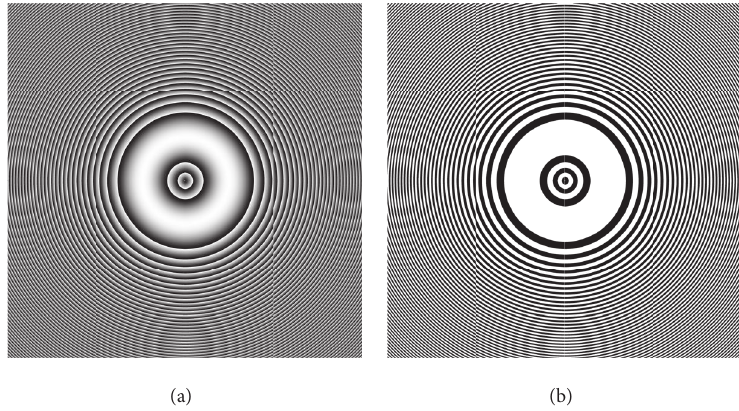
Figure 3: The phase distribution of the ideal diffractive kinoform (a) and binary (b) lens structure designed for the plane wave illumination, where white areas introduce 2 𝜋 (a) and 𝜋 (b) phase shift and black do not change the